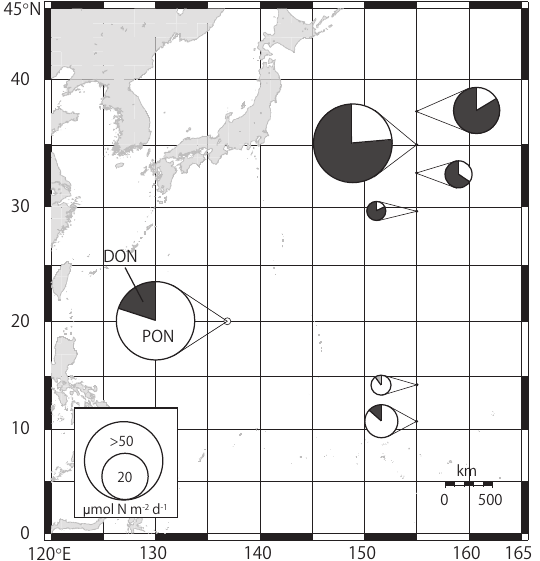
Fig. 3. Pie charts showing the distribution of N 2 fixation rates es- timated for particulate ( > 0.7µm) and filtrate ( < 0.7µm) fractions. The white and gray regions denote N 2 fixation in the particulate and filtrate fractions, respectively. For the stations where the N 2 fixation rates in the filtrate fraction were below the detection limit, the maximum values are shown in light gray.